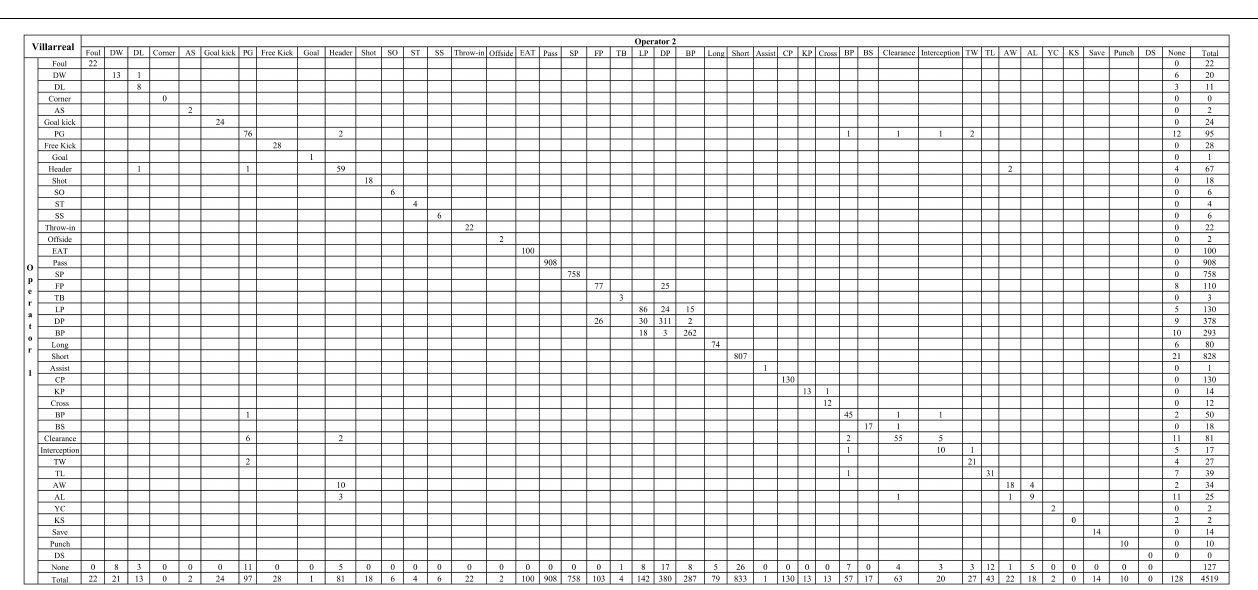
FIGURE 3 | Frequency of Real Madrid’s events recorded by the two independent operators in two collections. DW, dribble won; DL, dribble lost; AS, attacking shift; PG, possession gained; SO, shots off target; ST, shot on target; SS, shot saved; EAT, enter into attacking third; SP, successful pass; FP, forward pass; TB, through ball; LP, lateral pass; DP, diagonal pass; BP, backward pass; CP, consecutive pass; KP, key pass; BP, blocked pass; BS, blocked shot; TW, tackle won; TL, tackle lost; AW, aerial won; AL, aerial lost; YC, yellow card; KS, keeper sweeper; DS, deflected